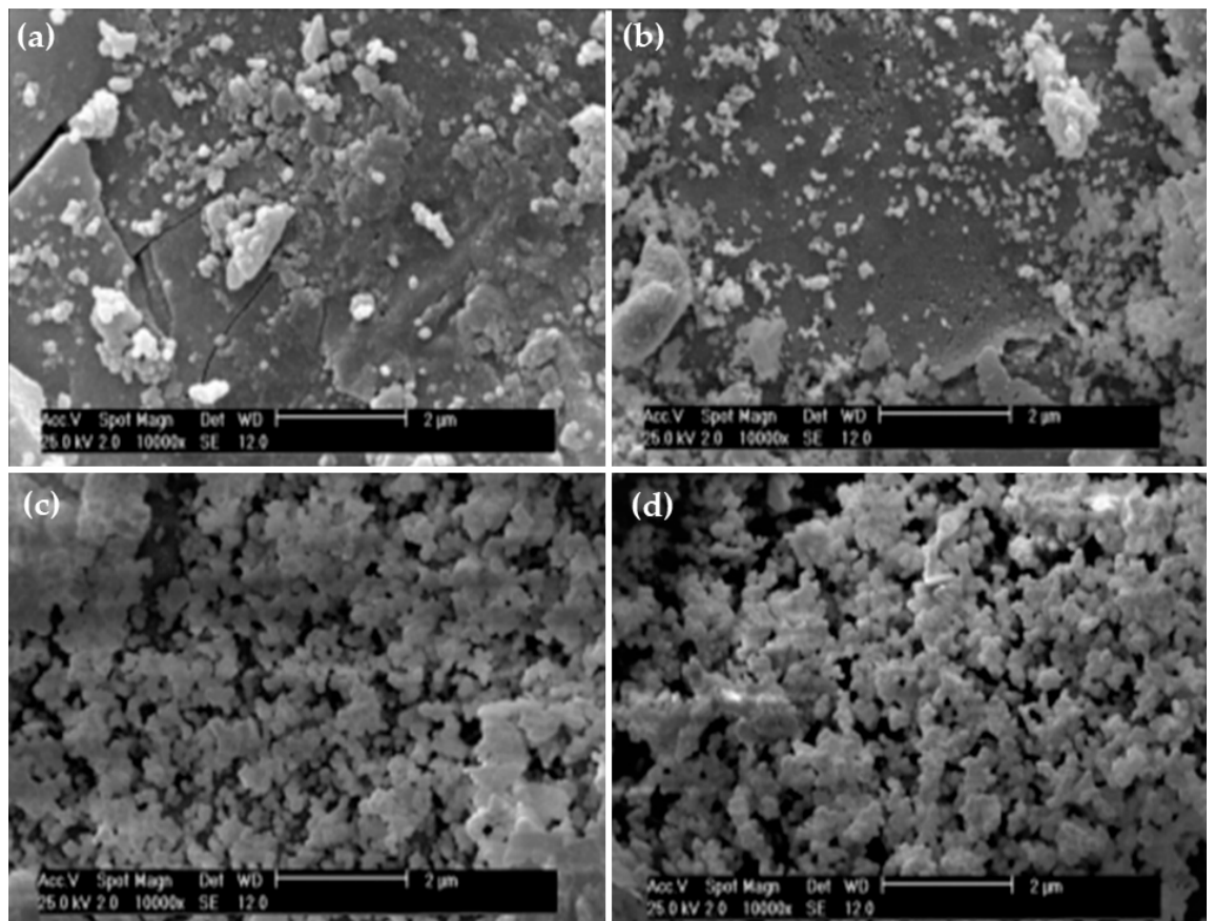
Figure 2. SEM micrographs of S6 BG sample after soaking in the simulated body fluid (SBF) solution for ( a ) 3 days, ( b ) 7 days, ( c ) 14 days, and ( d ) 21 days